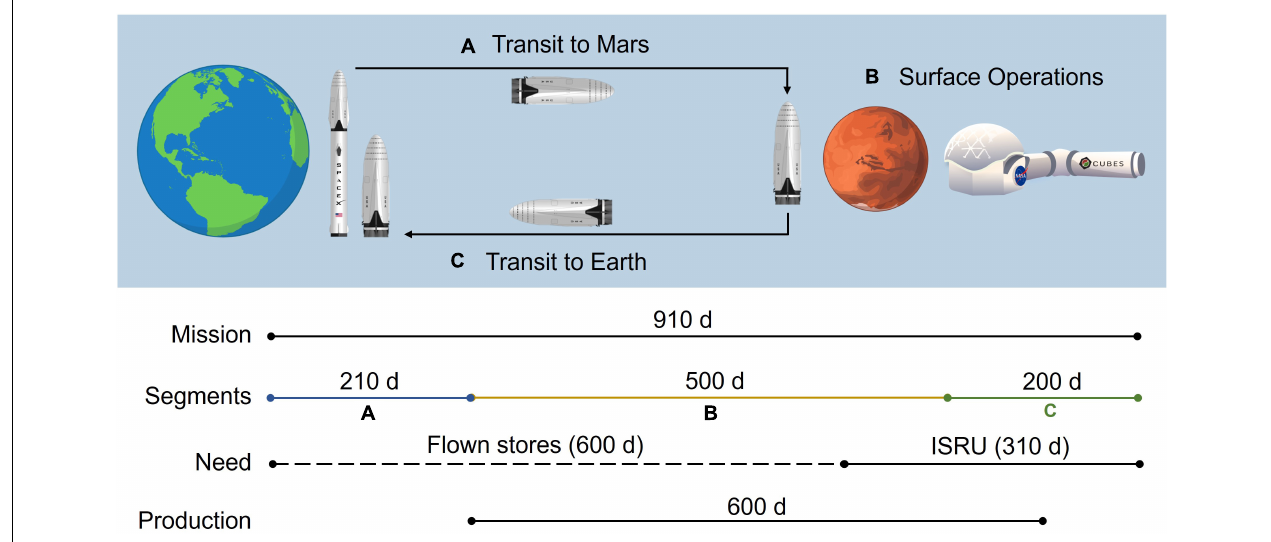
FIGURE 2 | An illustration of the reference mission architecture in which (A) a crewed ship is launched from the surface of Earth and lands on Mars and (B) assembles a pre-deployed habitat on the Martian surface to perform operations before (C) a return transit to Earth on the same ship. Pharmaceutical needs are supported by flown stores until partway through surface operations, at which point needs are met by pharmaceuticals produced using in situ resource utilization. Production is initiated prior to the need window to ensure adequate stocks are generated by the time it is needed. Rocket artwork adapted from Musk (2017). Habitat artwork by Davian